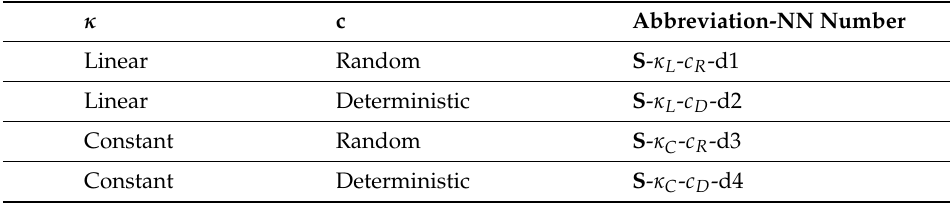
Table 1. Non porous (solid) analyses conducted.